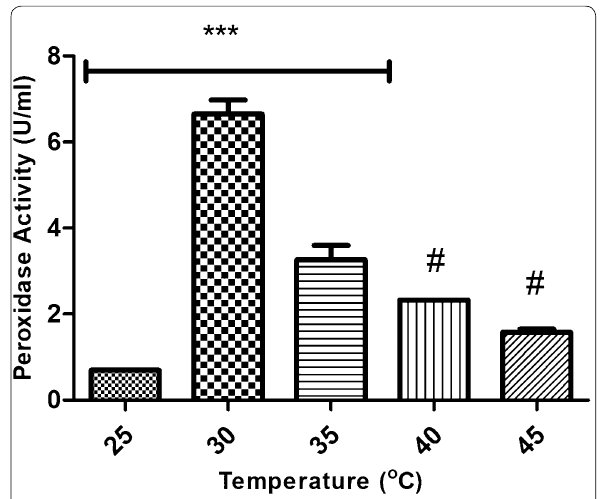
Fig. 2 Incubation temperature for optimum peroxidase activity expression by BMAB-1. Each column signifies mean ***Significantly different ( p < 0.05) while # not significantly different ( p >